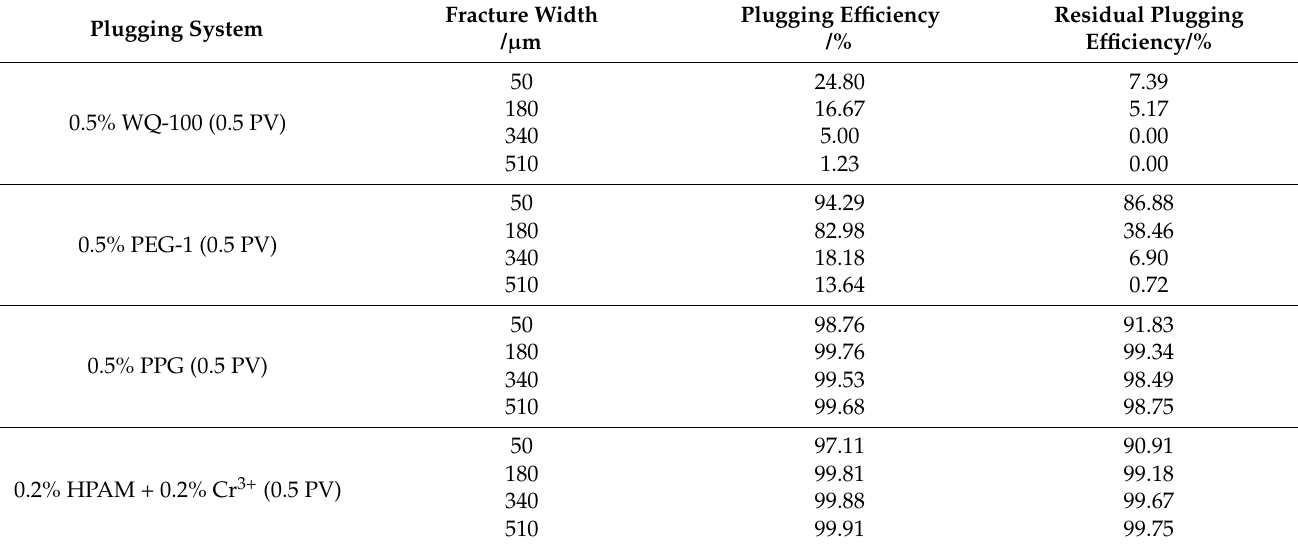
Table 6. Plugging efficiency of pre-crosslinking gel particle on the fractured reservoir.